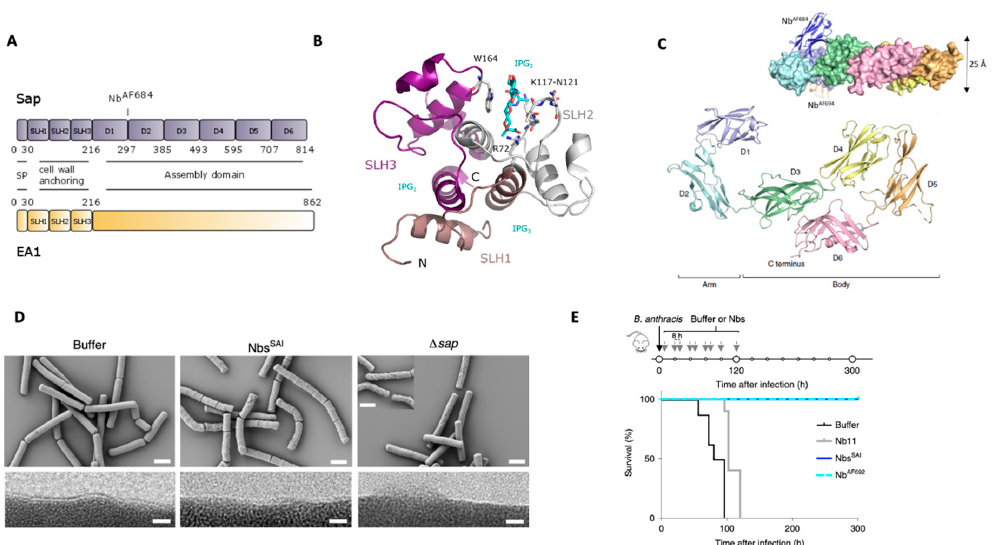
Figure 3. S-layer architecture of B. anthracis. ( A ) Domain architecture of Sap and EA1 S-layer proteins. The N -terminal ~216 residues comprise a signal peptide (SP) and a pseudo-repeat of three SLH motifs that form a cell-wall-anchoring domain. Sap assembly domain comprises of 6 independent domains as demonstrated by Sap AD crystal structure reported in Fioravanti et al., 2019 (PDB: 6HHU [19]). The site where the therapeutic nanobody AF684 is binding as in upper C panel is indicated (PDB: 6QX4 [19]). ( B ) Crystal structure of the cell-wall anchoring domain of Sap in complex with a synthetic SCWP unit (IPG). Each of the 3 SLH motifs are highlighted forming a pseudo-trimer shaping 3 SCWP-binding grooves (IPG1-3). Residues important in SCWP binding are highlighted. The S-layer is oriented away from the image plane (C-terminus) with the N -terminus and terminal SCWP unit facing toward us (PDB: 6BT4 adapted from [56]. ( C ) X-ray structure of Sap AD (residues 216–814) of Sap showing an arm-and-body organization composed of 6 β -sandwich domains. The inset shows the nanobodies used to solve the crystal structure. Notable Nb AF684 , which is binding the hinge region displays therapeutic activity. ( D ) Scanning and transmission electron microscopy (SEM and TEM, top and bottom row, respectively) representing the morphology defect of B. anthracis 34F2 cells treated with bu ff er or Sap assembly inhibitory nanobodies (Nbs SAI ), as well as RBA91 cells ( ∆ sap ) treated with bu ff er. RBA91 and cells treated with Nbs SAI present a scoured phenotype. TEM images show the loss of the ordered surface monolayer in RBA91 and in Nbs SAI -treated cells. Scale bars, 2 µ m and 10 nm for SEM and TEM images, respectively (adapted from Fioravanti et al., 2019). ( E ) Schematic of the treatment regime and survival curves (bottom) of B. anthracis infection and Nb treatment studies in mice. The treatment consisted of a 6 days course of 10 subcutaneous 100 µ L doses of 200 µ M Nbs or bu ff er after infection. Mice receiving bu ff er or Nb11 (a non-related S-layer Nbs) injections would succumb to lethal anthrax within ~110 h post infection; mice receiving Nbs SAI or Nb AF692 (the most potent Nbs SAI ) treatment are able to recover from the infection and survive anthrax disease. n = 8 mice per group. From Fioravanti et al.,